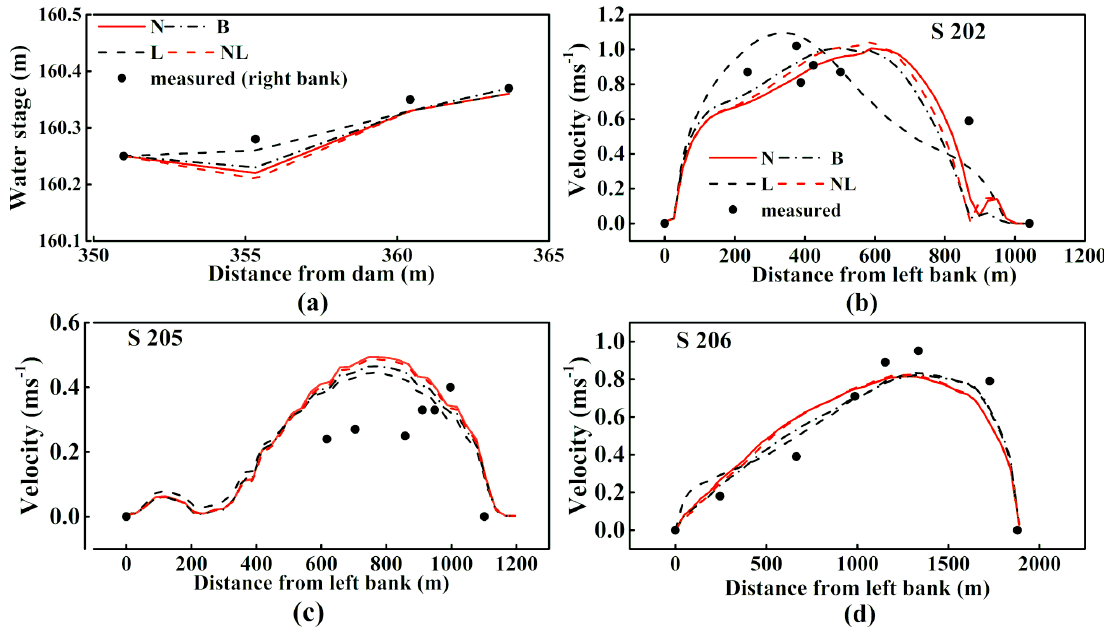
Figure 5. ( a ) Water stage of the right bank (downstream view). ( b – d ) Depth-averaged